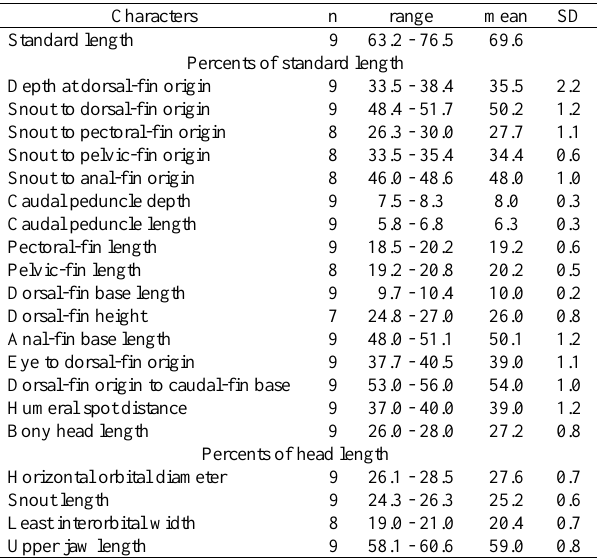
Table 12. Morphometrics of Charax notulatus . Specimens are from MZUSP 28659, USNM 233624, 260305,